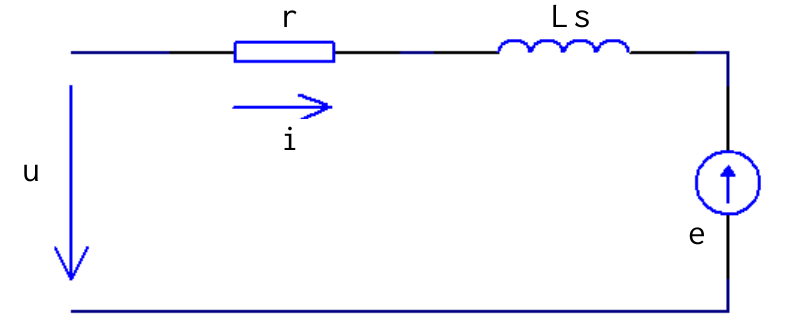
Figure 2. The equivalent circuit of one phase. The voltage of one phase can be expressed as